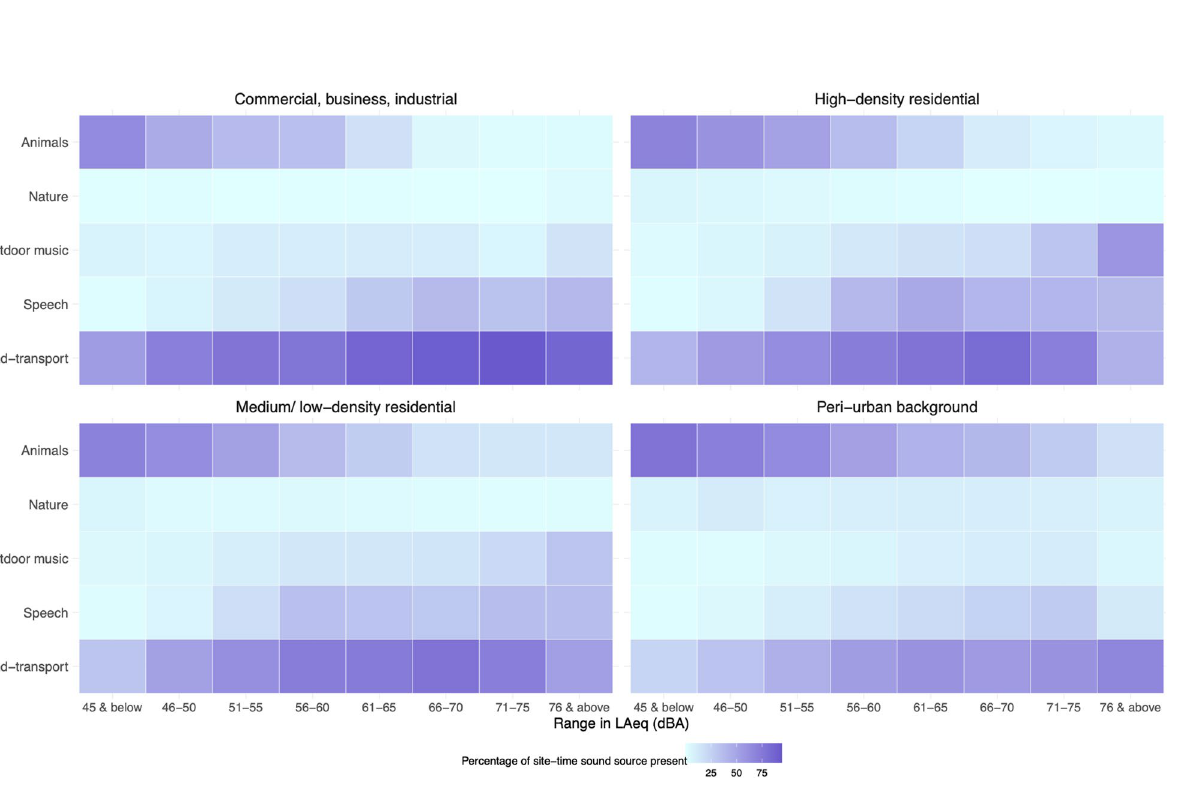
Figure 3. Prevalence of sound sources within land use areas and varying sound levels (LAeq 1min ) in the Greater Accra Metropolitan Area. Data from rotating sites. The percentage of site-time that each sound source was present was calculated from the data within each land use area and sound level interval